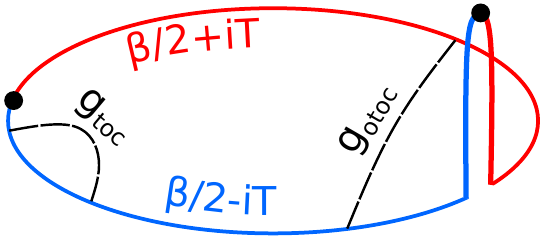
Figure 6 . Contour relevant for matrix element of journal. This can be obtained by considering a red segment of length τ and a blue segment of length β − τ , and then setting τ = β/ 2 + iT . partially correlated between these two segments. Let us assume the correlation between the couplings on the two sides is λ 2 = e − µ . When λ = 1 there is no change in the coupling at the quench sites; when λ = 0 the two sides are uncorrelated. The large q equations